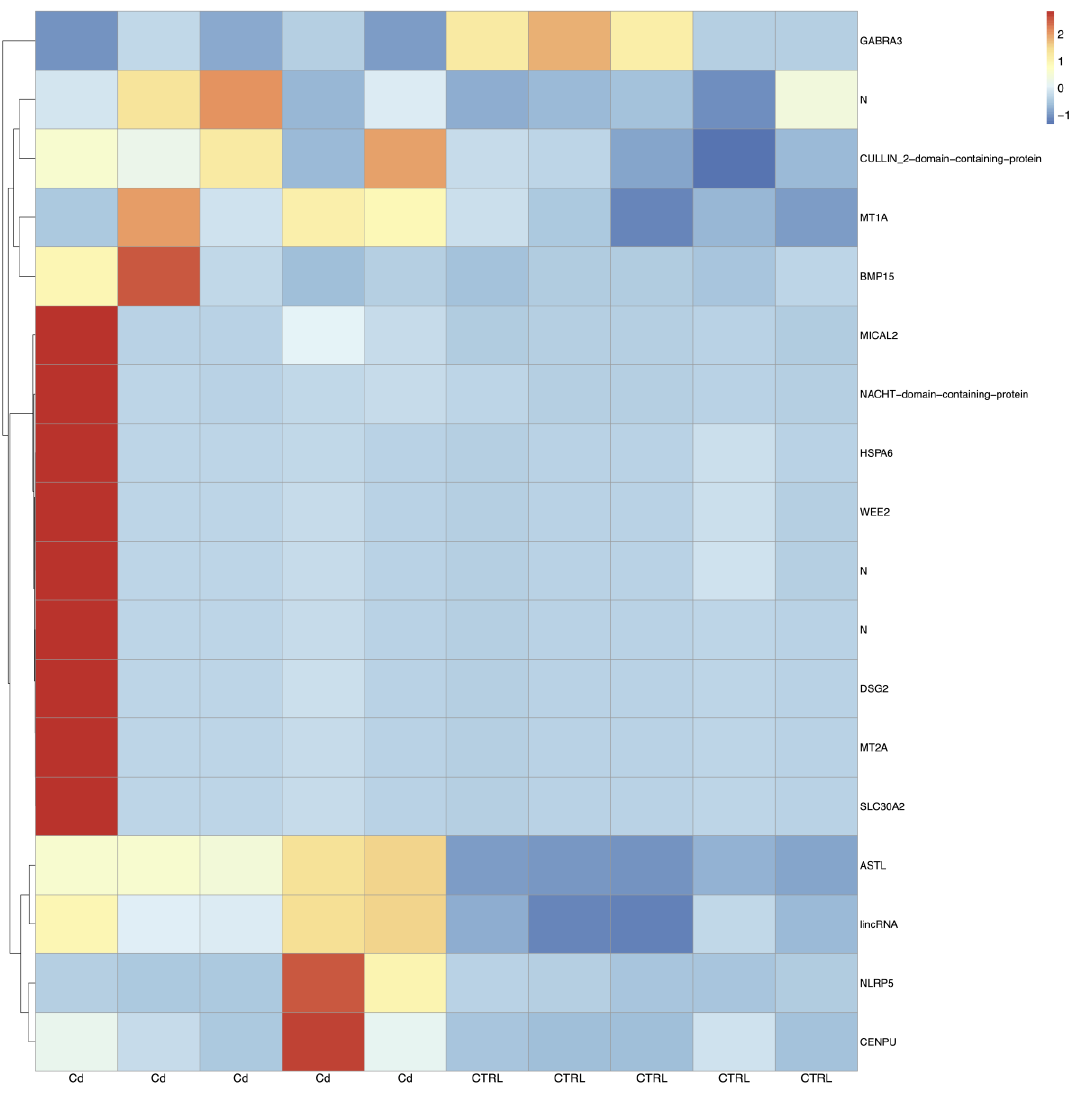
Figure 3. Heatmaps of DEGs in prepubertal CCs between the Cd-induced group and control group. Blue to red colouration denotes low to high expression levels, respectively. Abbreviations: Cd, cadmium; CTRL, controls.